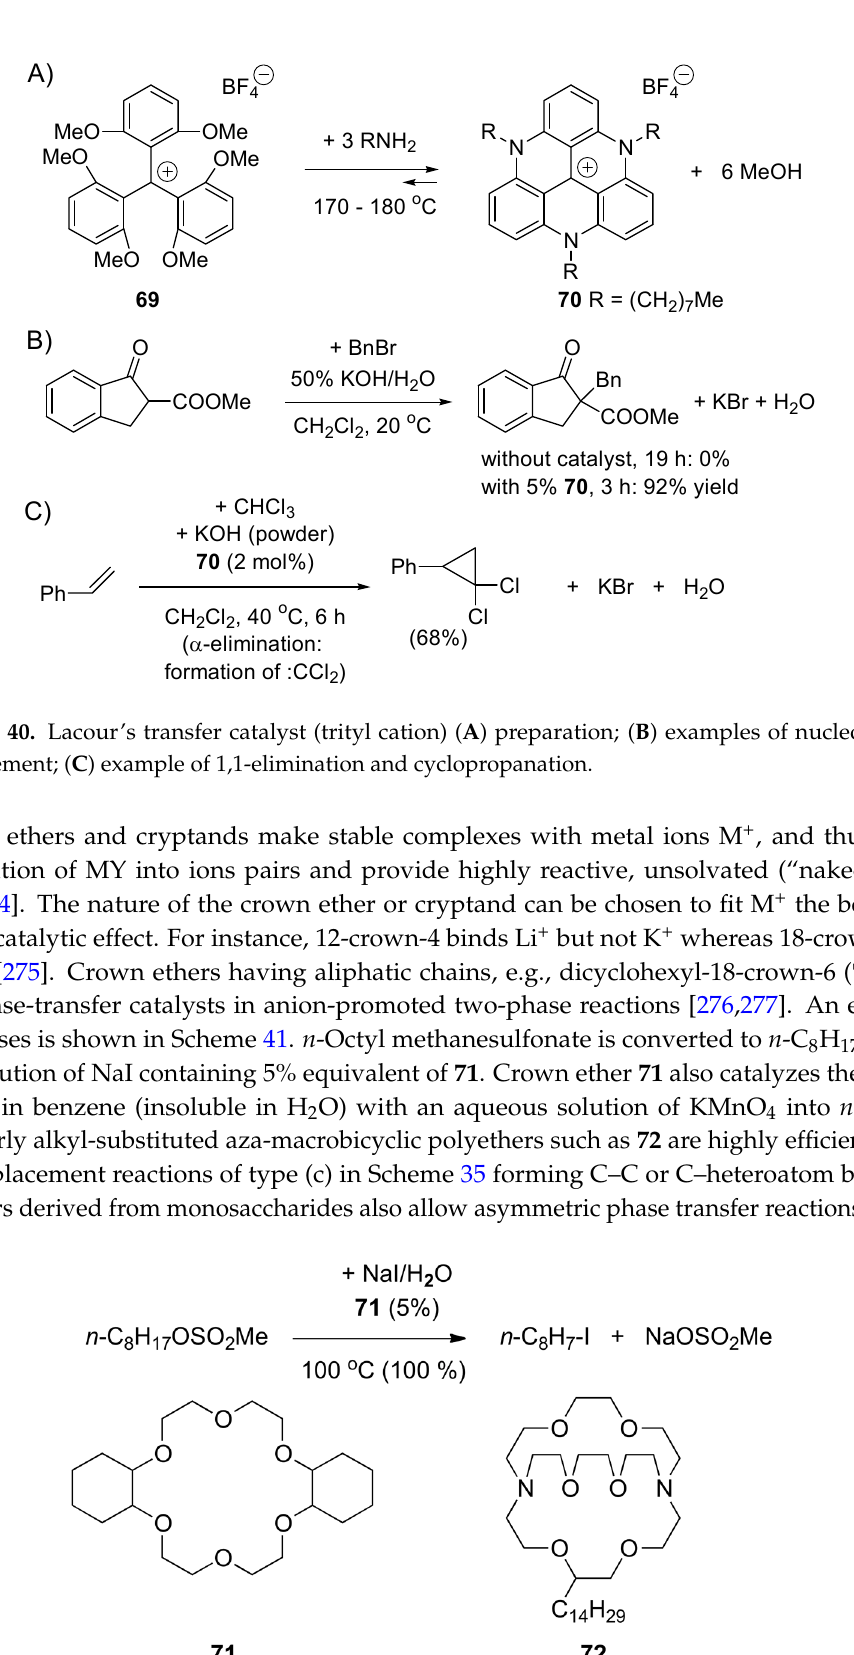
Scheme 41. Catalysis of S N 2 reactions by crown ethers.